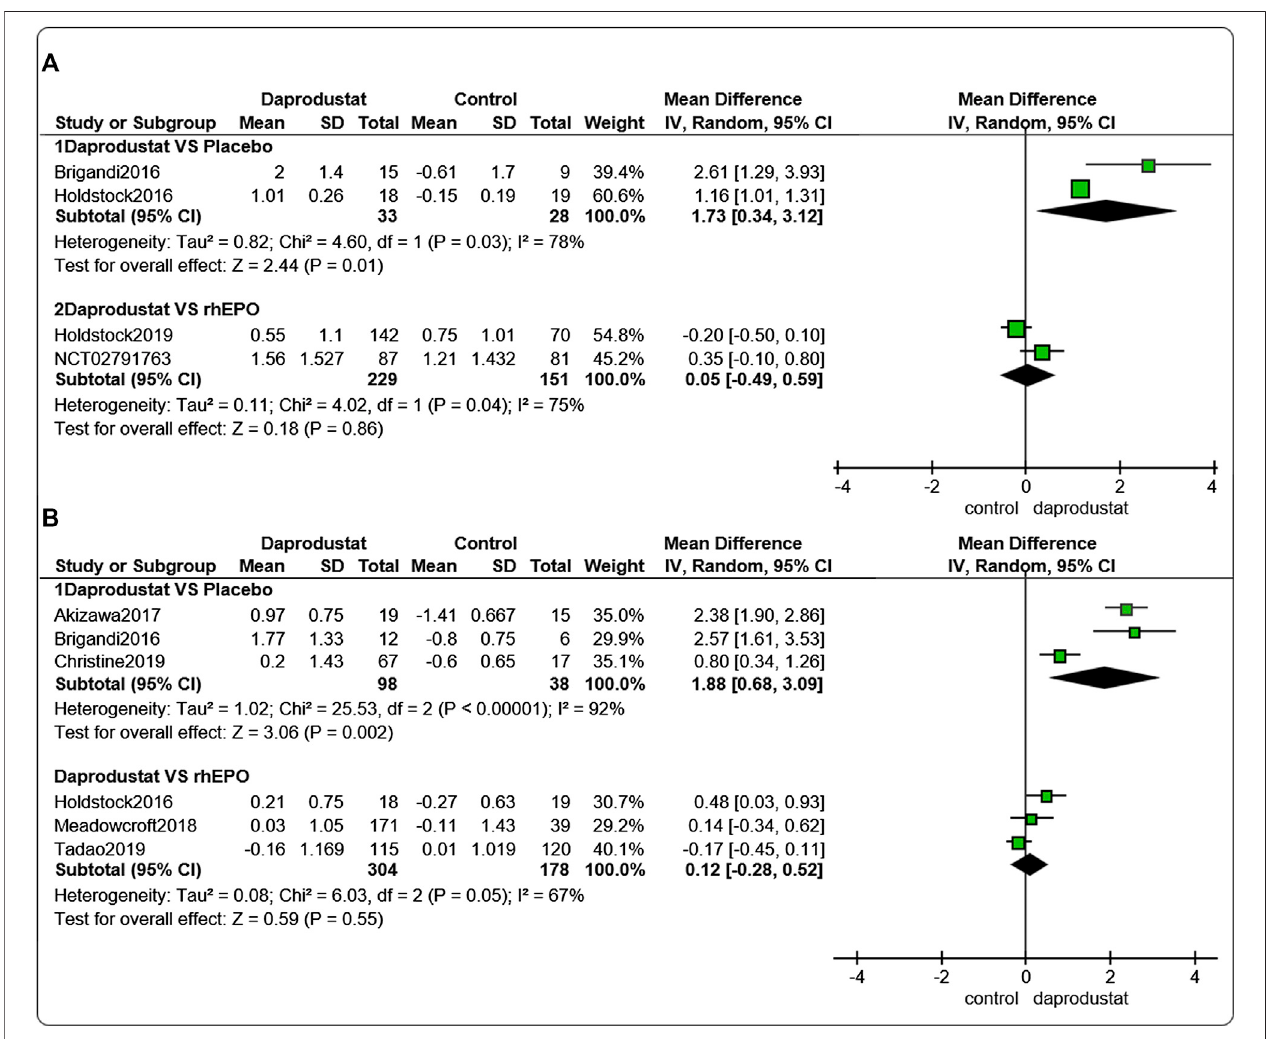
FIGURE 3 | The meta-analysis results of daprodustat for △ Hb. (A) The pooled results for NDD patients; (B) The pooled results for DD patients.